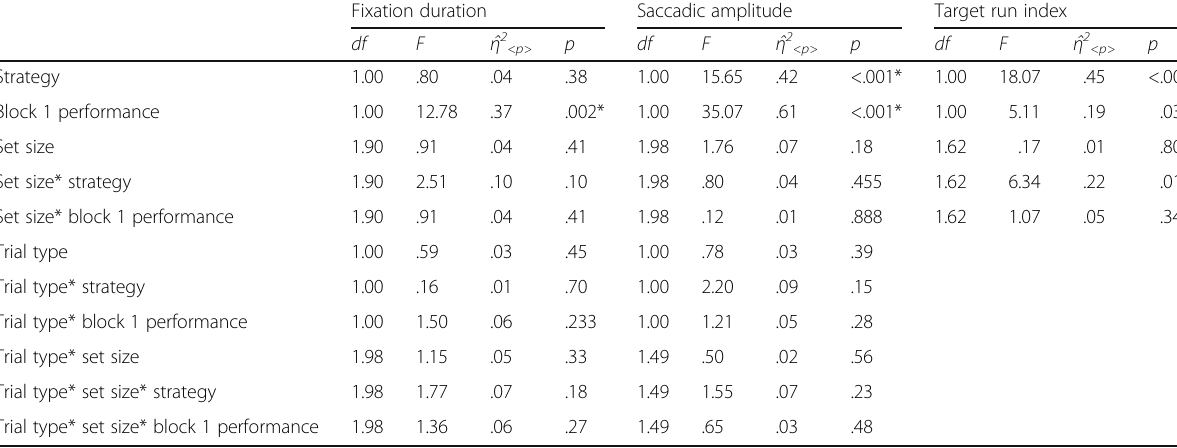
Table 3 Full results of analysis of covariance (ANCOVA) for oculomotor behavior in experiment